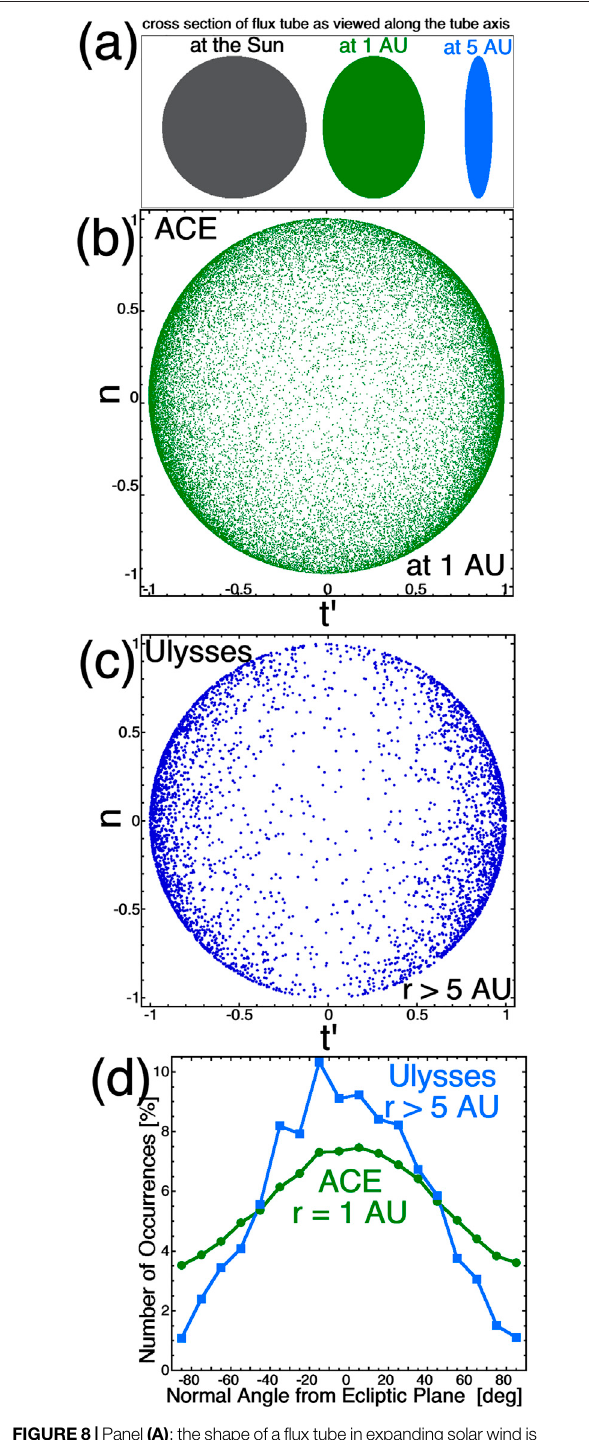
FIGURE8 | Panel (A) :the shape ofa fl ux tube inexpandingsolar wind is indicated at three distances from the Sun (as viewed along the local Parker- spiral direction). Panel (B) : the orientations of the normals to 40351 current sheets in the solar wind at 1 AU as viewed along the nominal Parker- spiral direction. Panel (C) : the orientations of the normals of 4019 current sheets in the solar wind at ∼ 5 AU as viewed along the nominal Parker-spiral direction. Panel (D) : the distribution of discontinuity normal directions away from the solar-equatorial plane is plotted at 1 AU (green) and ∼ 5 AU (blue).